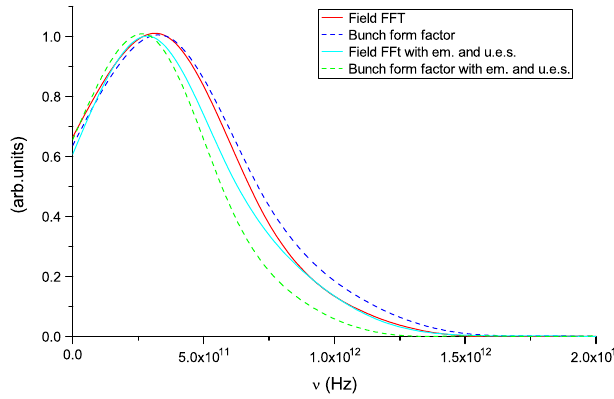
14. (Color) Field fast Fourier transform (FFT) and bunch form factor for a beam with and without emittance and uncorre- lated energy spread and for a bunch with (cid:5)E=E ¼ 0 : 6% and (cid:11)